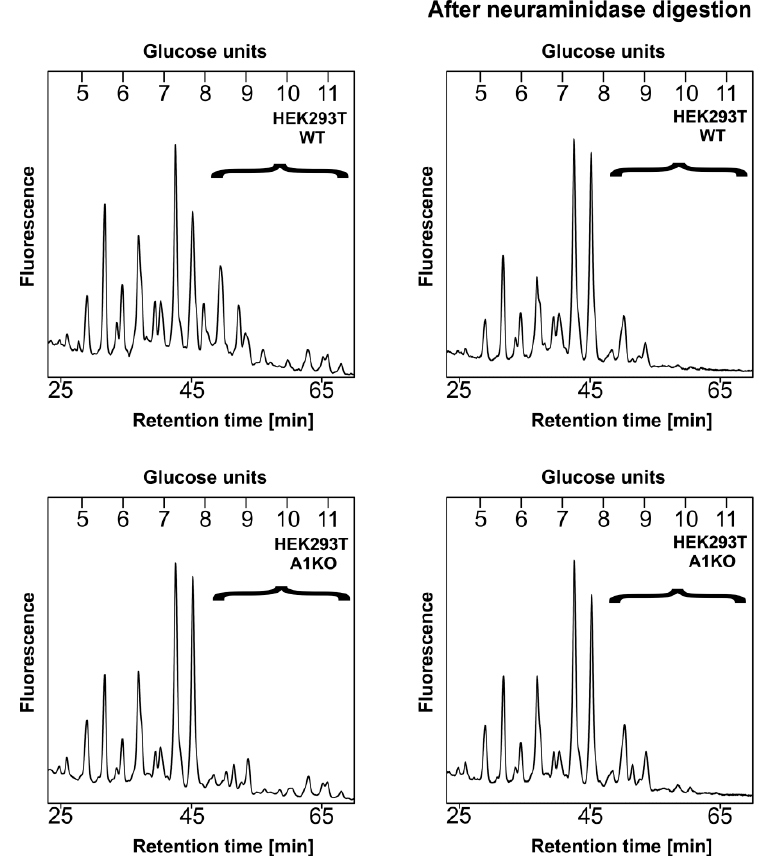
Figure 5. HPLC analysis of N-glycans released from the secreted reporter glycoprotein. N-Glycans derived from a modi- fied SEAP overexpressed in wild-type (WT, top panel) and CST-deficient (A1KO, bottom panel) HEK293T cells were fluorescently labeled with 2-AB, purified and separated on the normal phase GlycoSep N column using HPLC. The left panel represents intact (undigested) structures, while the right panel corresponds to structures obtained upon a neu- raminidase treatment. Respective glycans are expressed in glucose units. Sialylated structures are enclosed in brackets. Representative data from two independent analyses with a similar tendency are shown. A1,